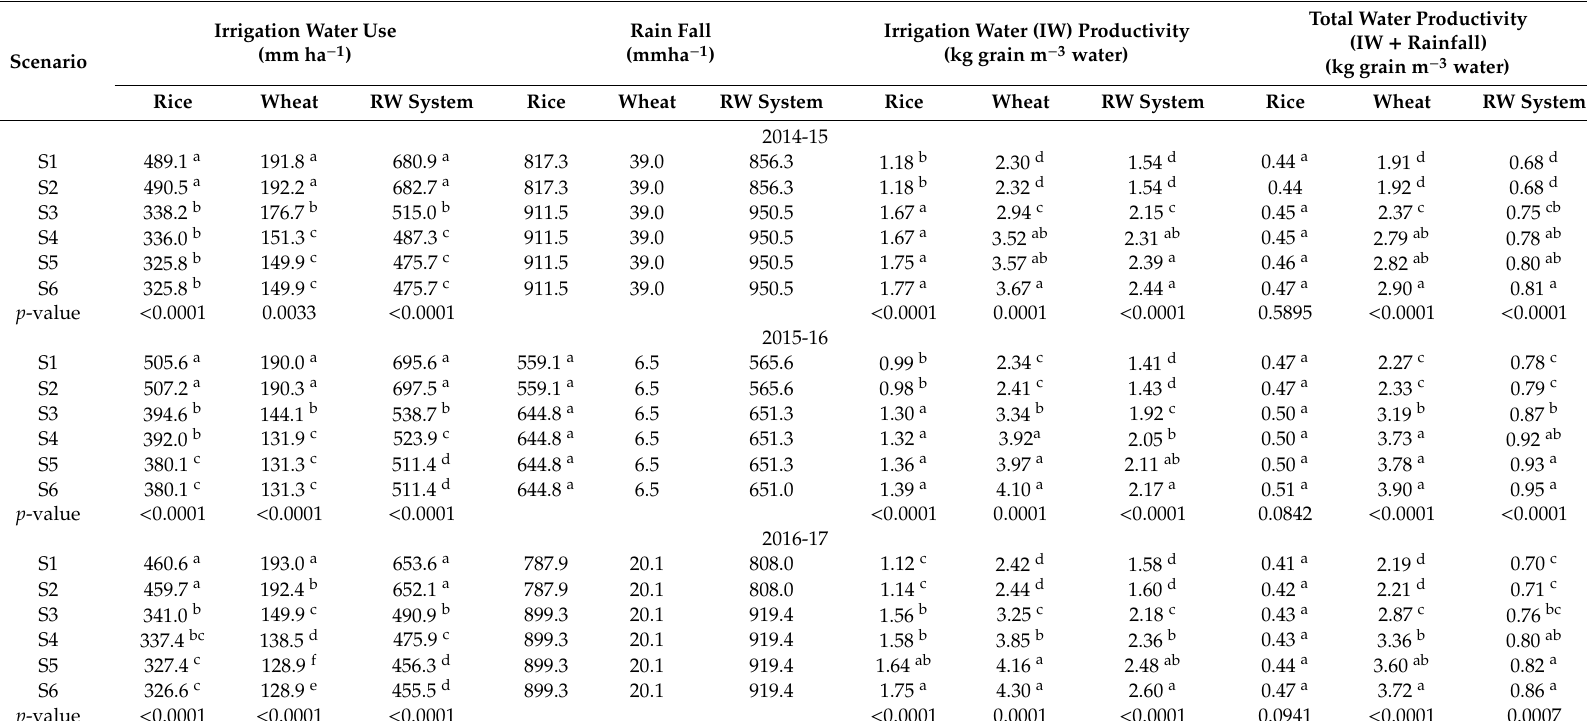
Table 7. E ff ect of di ff erent portfolios on irrigation water use and water productivity under divergent crop management scenarios during a 3-year study.